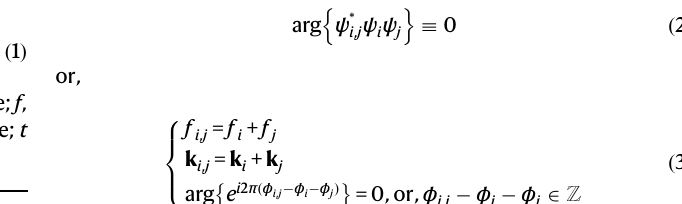
Table 1 | Spectral peaks in Fig. 2 and their